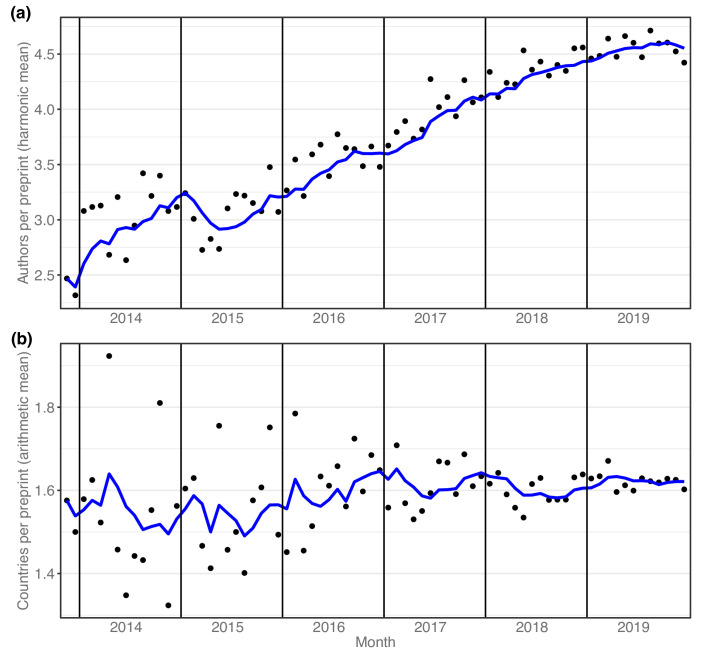
Preprint-level collaboration.(a) shows the average number of authors per paper over time. The x-axis indicates the year; the y-axis indicates the harmonic mean authors per preprint. Each point indicates the average of papers posted in a single month; the blue line indicates the six-month moving average. (b) illustrates the number of countries per preprint, over time. The x-axis indicates time; the y-axis indicates the arithmetic mean countries per preprint. Each point indicates the average unique countries found in all preprints posted in a single month. The blue line indicates the six-month moving average.